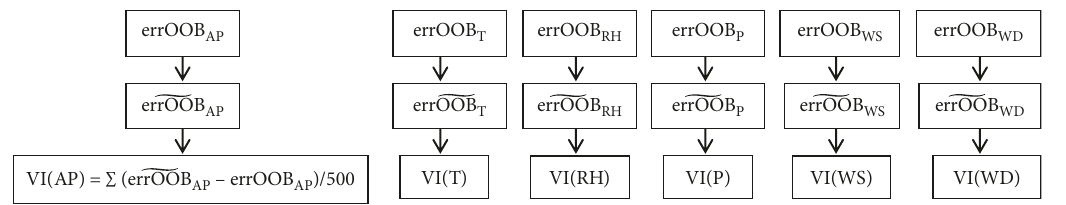
Figure 2: Importance scores of six meteorological